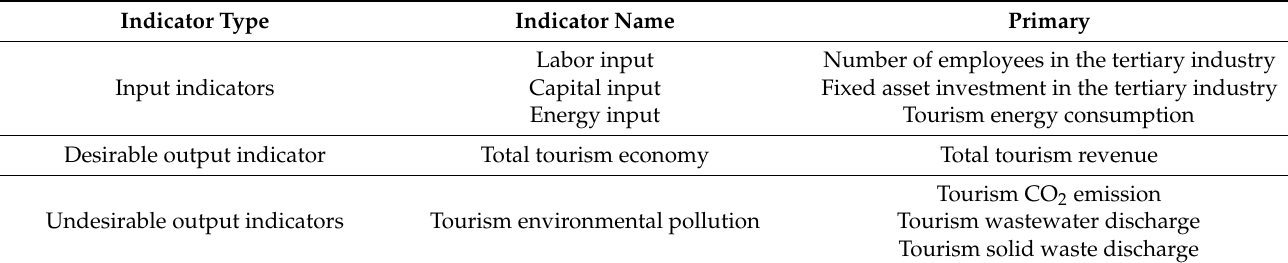
Table 1. Input–output indicators